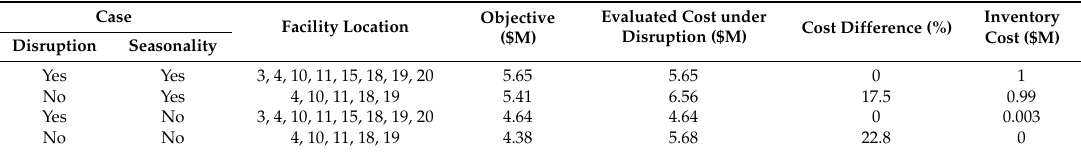
Table 3. Solutions statistics for the four